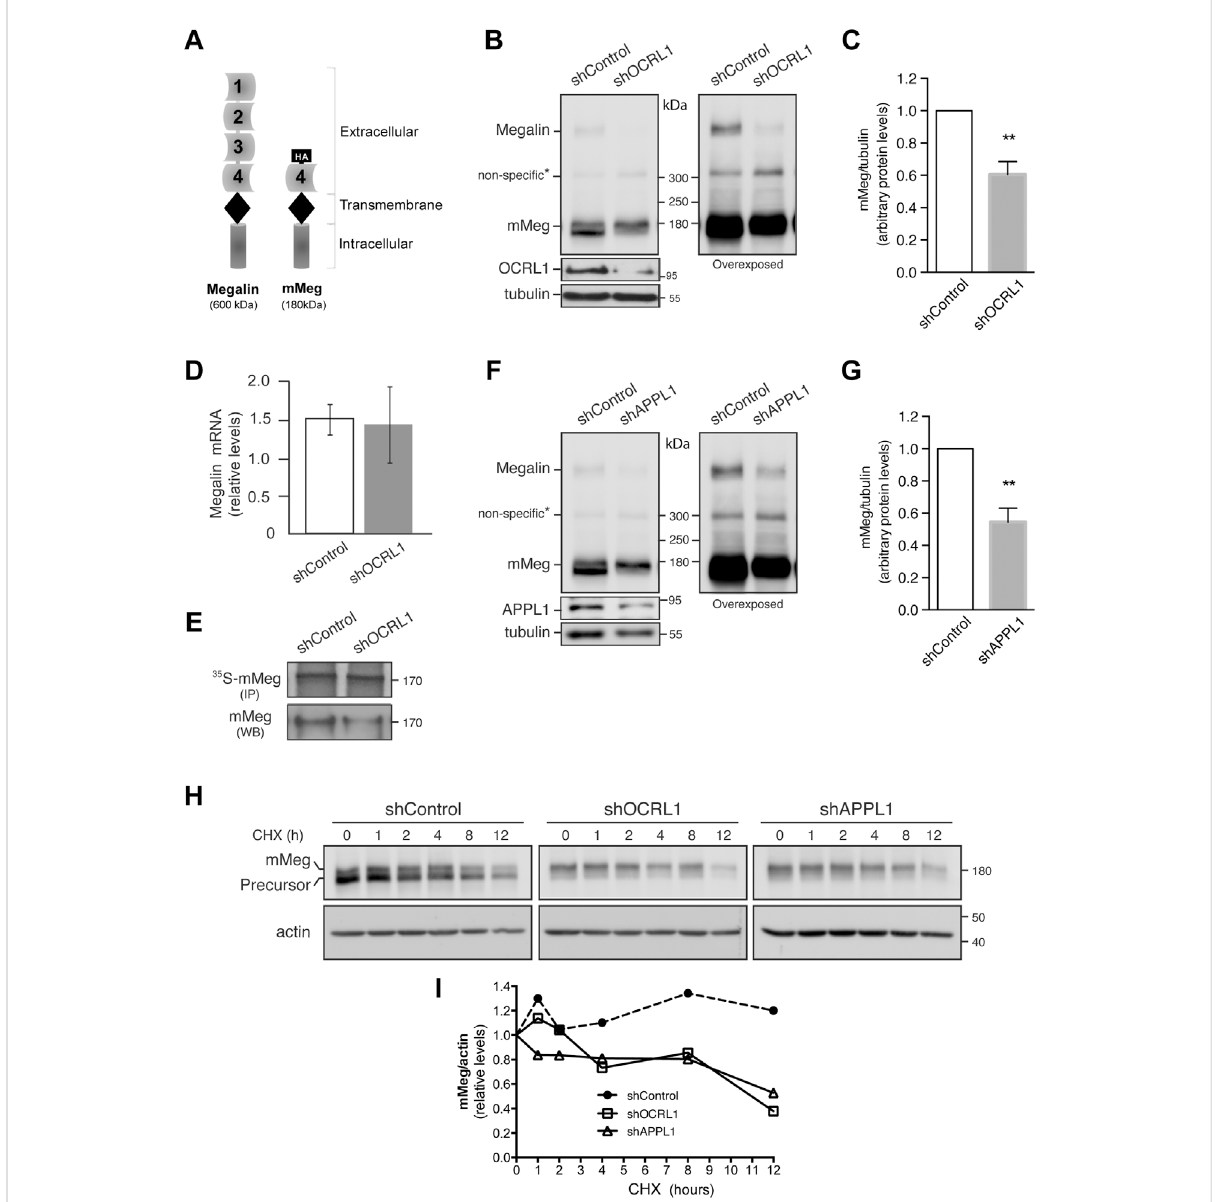
FIGURE 1 Megalin is down-regulated in OCRL1 and APPL1 KD proximal tubule cells. (A) Schematic representation of the full-length megalin with its four ligand-binding domains and the mini receptor with the fourth ligand-binding domain tagged with HA-epitope (mMeg). (B – H) LLC-PK1 cells stably expressingmMeg(mMeg-LLC-PK1)wereinfectedwithnon-targetshRNA(shControl),shRNAdirectedagainstOCRL1(shOCRL1)orAPPL1(shAPPL1) lentiviruses. (B) Endogenous megalin and mMeg were analyzed in whole-cell lysates of control and OCRL1 silenced cells by western blot. (C) Quanti fi cation of mMeg protein levels corrected with tubulin levels in control and OCRL1 KD cells. Data are expressed as the means ± SEM of N = 5 independent experiments ( t -test, ** p < 0.01). (D) Quantitative PCR was used to analyze mRNA levels of megalin. Three independent assays were performed, and the average ±SD was plotted on the graph. (E) Metabolic labeling of control or OCRL1 silenced cells with [ 35 S]-methionine/cysteine for4 hmMegwasimmunoprecipitated(IP)andanalyzedbyautoradiography.Additionally,analiquotofthewhole-celllysatewasusedtototalmMeg bywesternblot(WB). (F) EndogenousmegalinandmMegwereanalyzedinwhole-celllysatesofcontrolandAPPL1silencedcellsbywesternblot. (G) Quanti fi cation of mMeg protein levels corrected with tubulin levels in control and APPL1 KD cells. Data are expressed as the means ± SEM of fi ve independent experiments ( t -test, ** p < 0.01). (H) Control or silenced cells were treated with CHX (100 μ M), and the expression of mMeg, Precursor- mMeg, and actin were determined by western blot at indicated times. (I) Graph corresponds to mMeg protein levels corrected with actin levels in control and silenced cells.